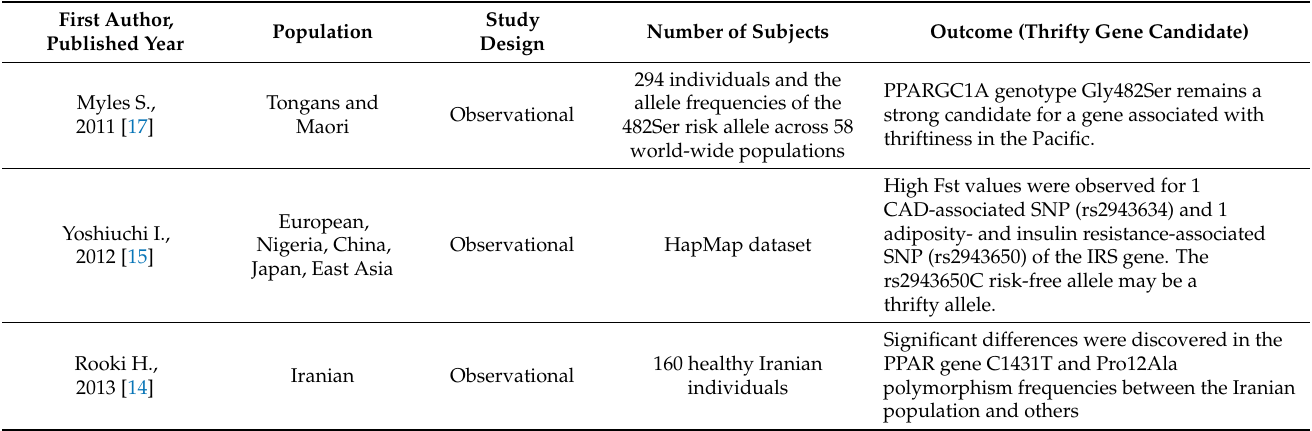
Table 1. Characteristics of selected